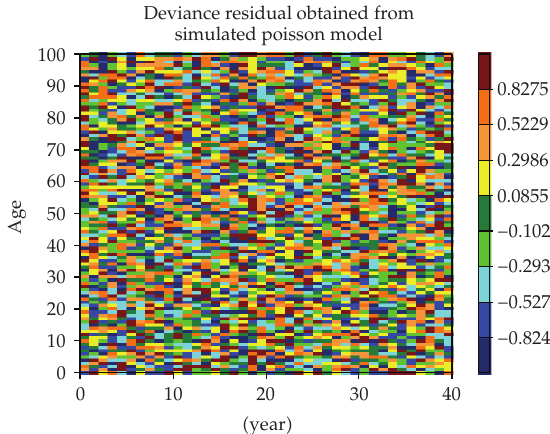
Figure 6: Contour map for simulated deviance residuals.